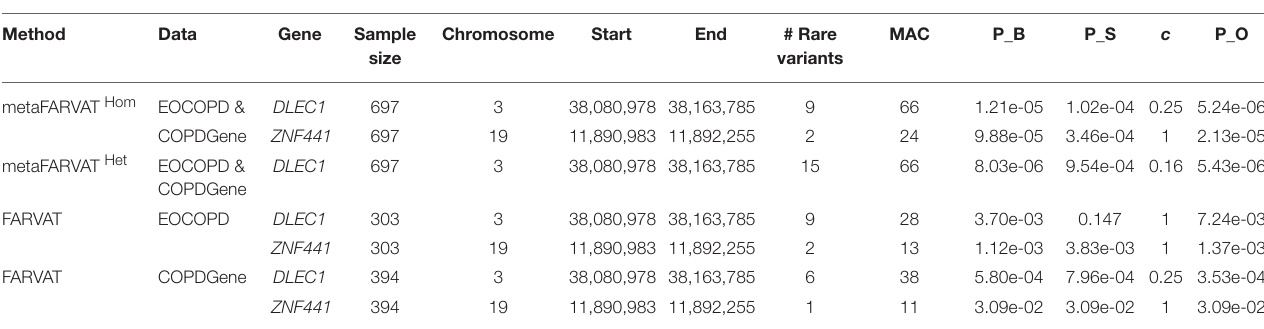
TABLE 4 | The candidate genes found by meta-analysis in COPD